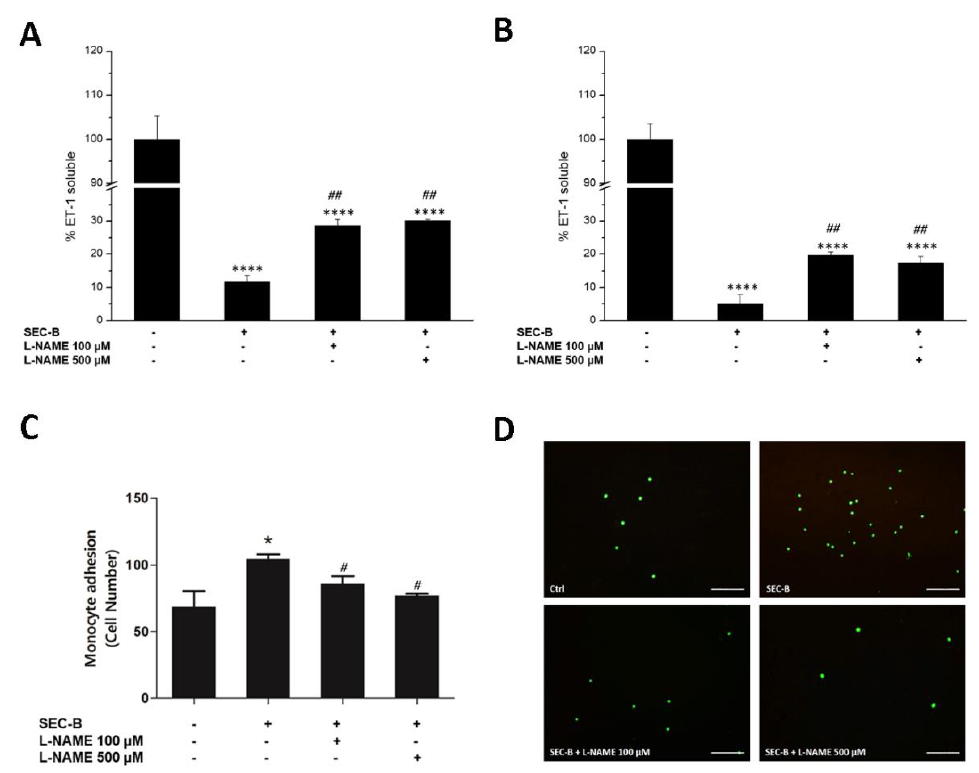
Figure 7. Inhibition of NOS decreases HMEC-1 cell activation. Pre-treatment with L-NAME (100 µM and 500 µM) increased soluble ET-1 levels in HMEC-1 cells after 4 h ( A ) and 24 h ( B ) of SEC-B administration. ( C ) Quantification of the number of bound U937 cells in six randomly selected images with 10× magnification. ( D ) Representative fluorescence images showing the effects of L-NAME on adhesion of calcein-AM-labeled U937 cells to HMEC-1 treated for 24 h with SEC-B. The images are obtained by optical fluorescence microscopy using the 10× objective Scale bar: 200 µm. Data are expressed as mean ± SD ( n = 3). * p < 0.05 , **** p < 0.0001 vs. untreated cells; # p < 0.05, ## p < 0.01 vs. SEC-B-treated cells.